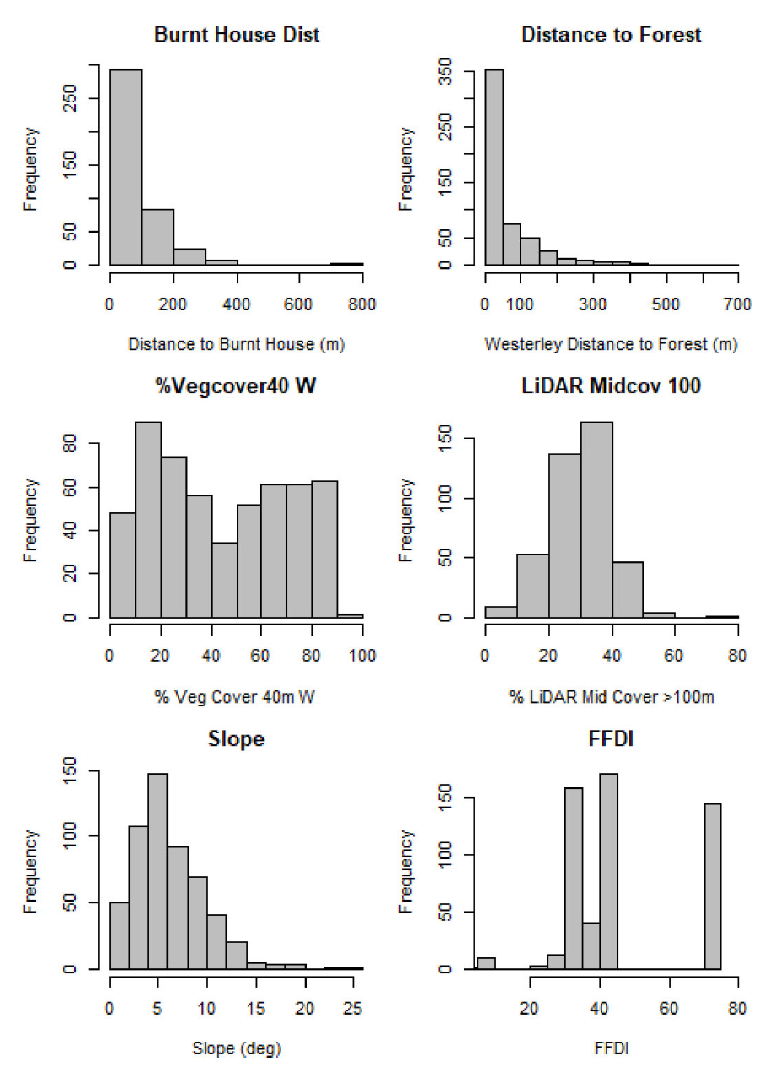
Figure 3. Distributions of values for six variables that feature in the final model or represent the themes. Refer to the text and Table 1 for descriptions. Light Detection and Ranging (LiDAR) data were collected in the area around the Linksview Fire in February 2011 (20 months before the fire) by the NSW Department of Land and Property Information. The point data consisted of up to five returns per pulse and a mean point density of 1.05 m − 2 . These data were processed using GIS to estimate the cover of commonly defined fuel strata (near surface, elevated and trees, [49]) in zones overhanging 2, 2–10, 10–30 and 30–100 m around each house, using the methods described in Price and Gordon [50]. Near ‐ surface fuels are suspended above the ground to a height of 50 cm. Elevated fuels equate to the shrub layer and were defined as 0.5–4 m above the ground, and trees were divided into mid (4–8 m) and upper (>8 m) tree cover. LiDAR cannot, however, be used to estimate surface fuel (e.g., leaf litter) which is an important predictor of fire behaviour [41, 49], so we had no surface fuel measures beyond the garden descriptions